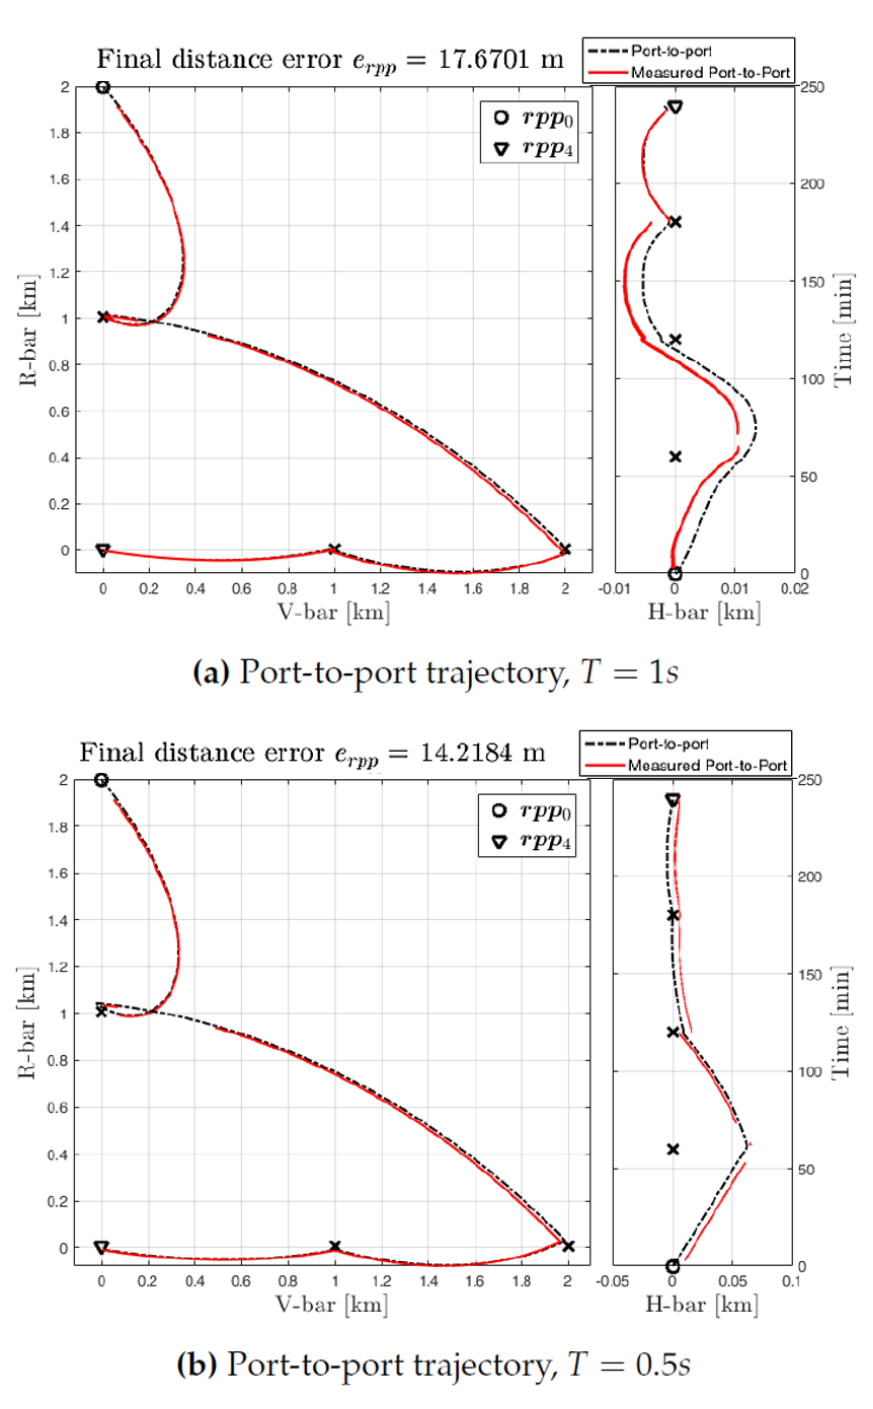
Figure 22. Trajectories varying the PWM frequency (optimal